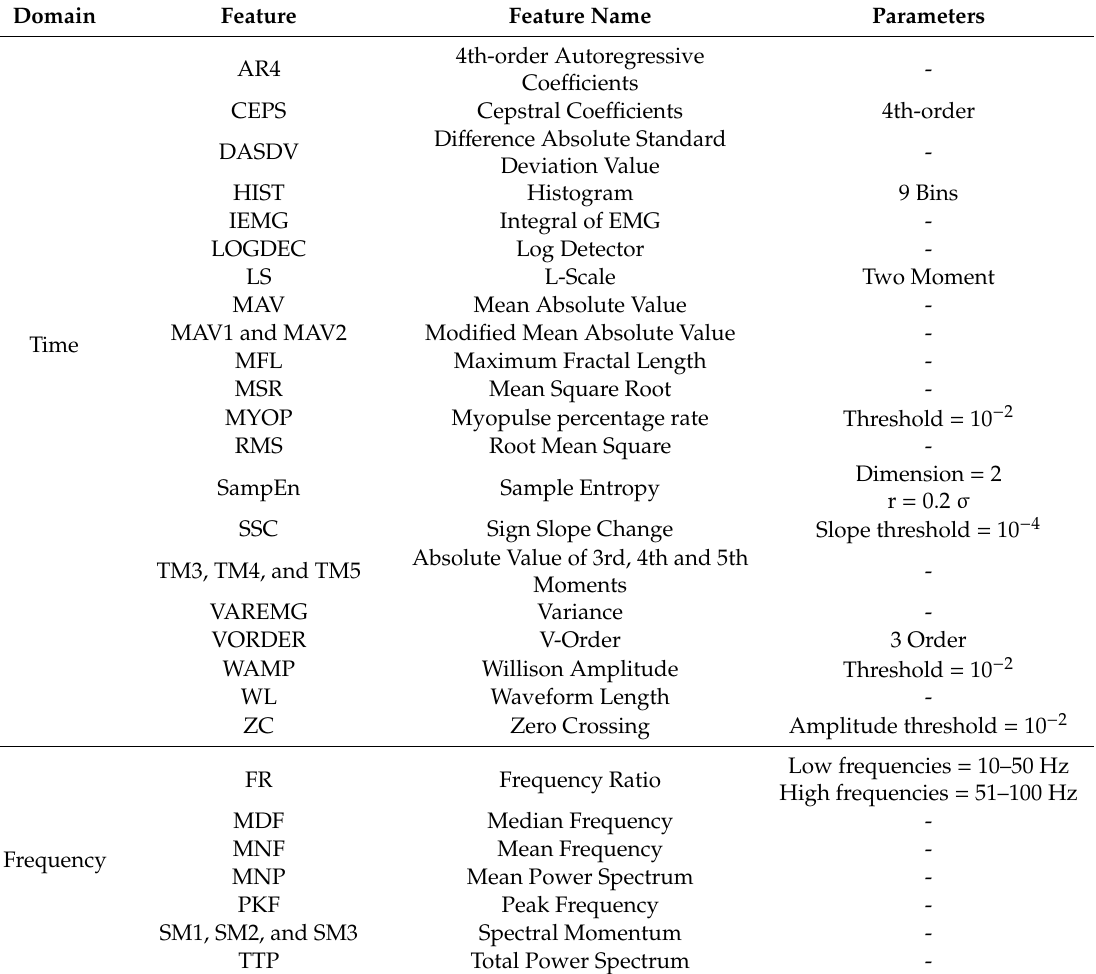
Table 1. Time-domain and frequency-domain features extracted from this